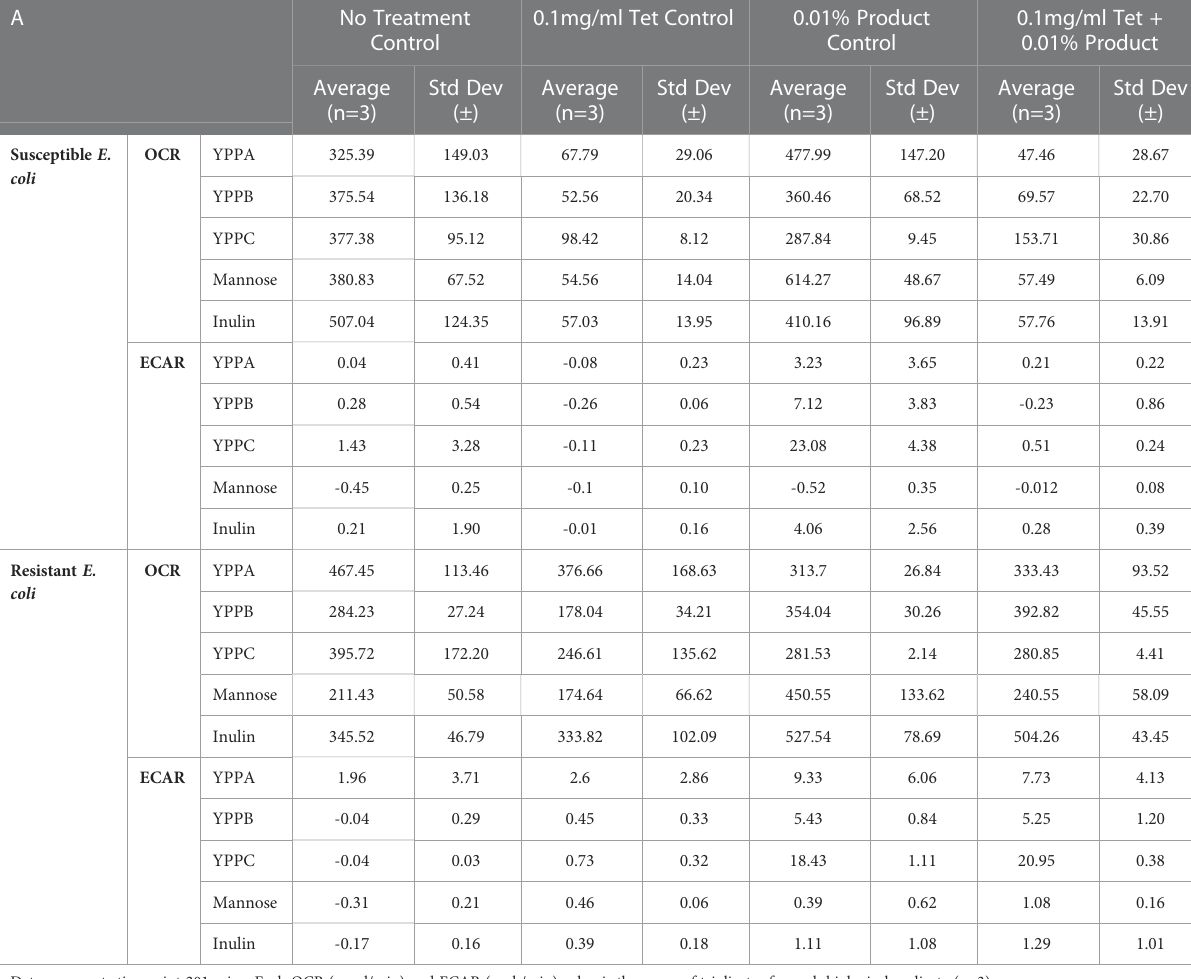
TABLE 2A OCR and ECAR results for susceptible(S) and resistant (R) E. coli when treated with 0.01% (w/v) YPPA, YPPB, YPPC, mannose or inulin with and without tetracycline (0.1mg/ml). A